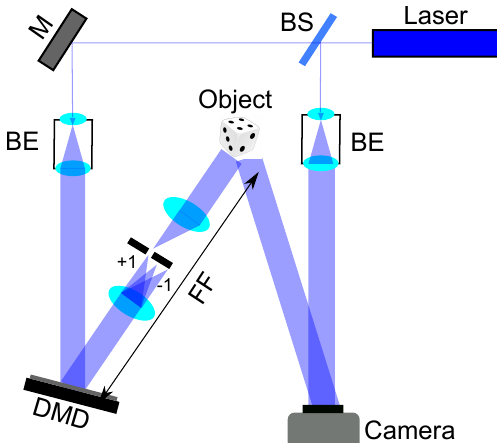
Digital holographic recording setup with a Digital Micromirror (DMD) for phase modulation. BE: Beam Expander, BS: Beam Splitter, DMD: Digital Micromirror Device, M:Mirror, FF: Fourier